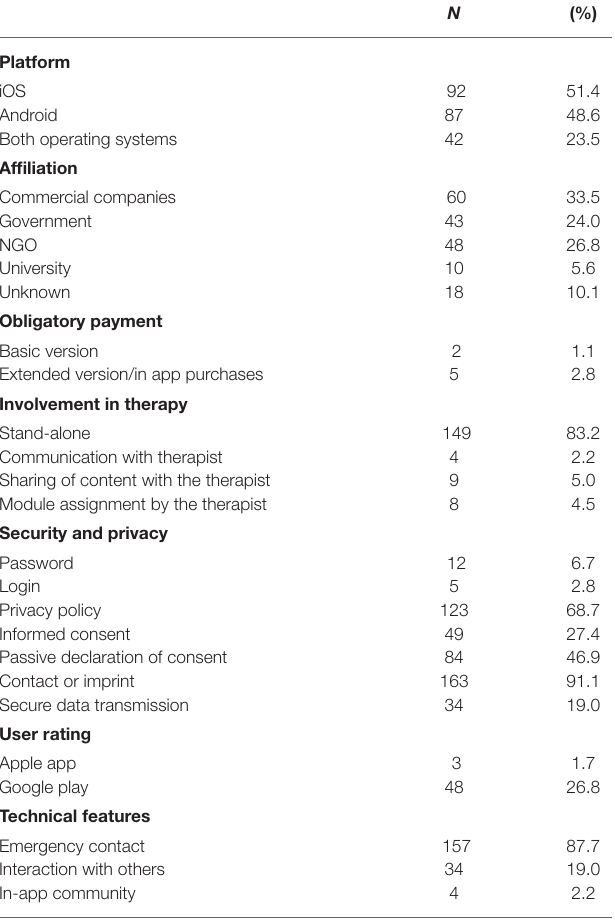
TABLE 1 | General characteristics of the included MHA for suicide/NSSI prevention.